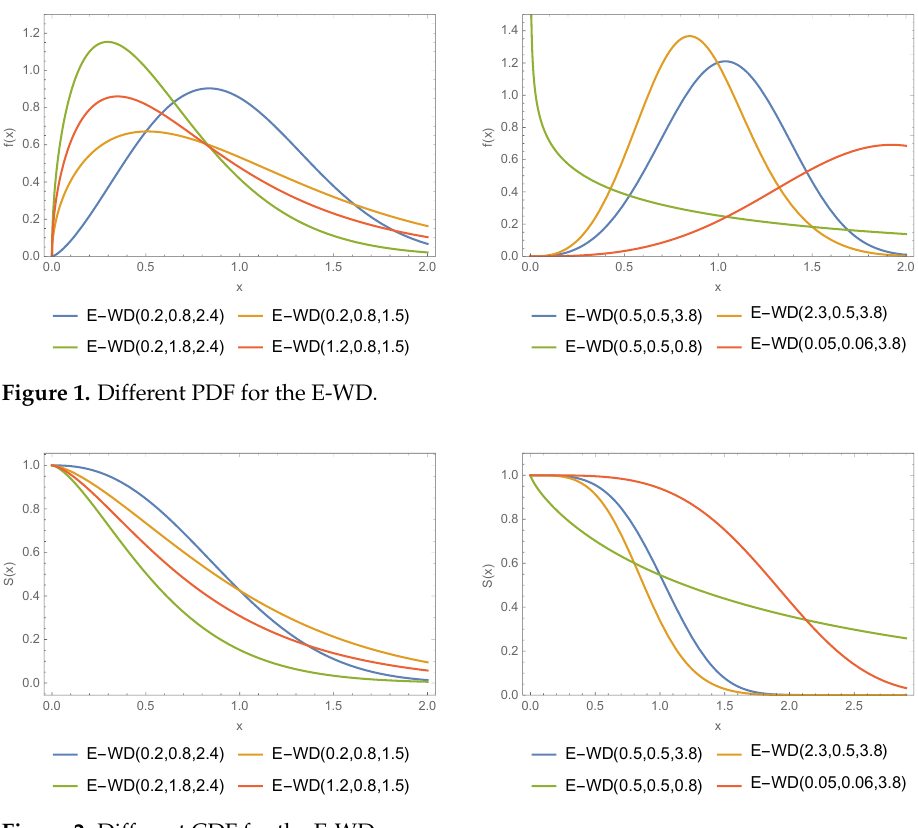
Figure 2. Different CDF for the